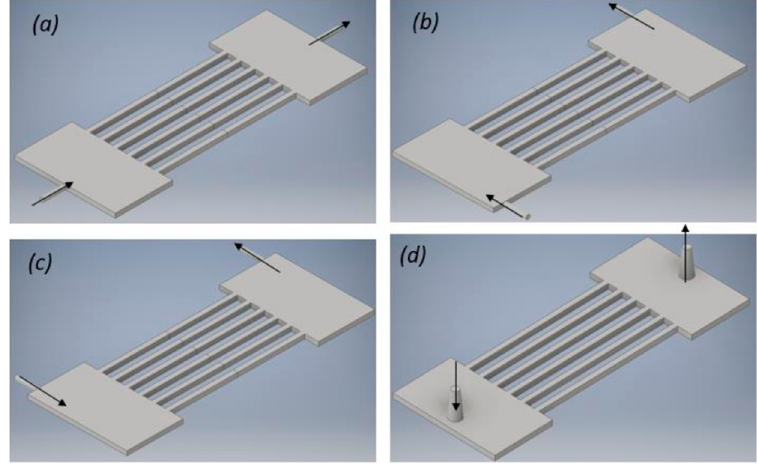
Figure 10. Different configurations for the microchannel device: ( a ) horizontal frontal; ( b ) horizontal parallel; ( c ) horizontal parallel inverted; ( d ) vertical.